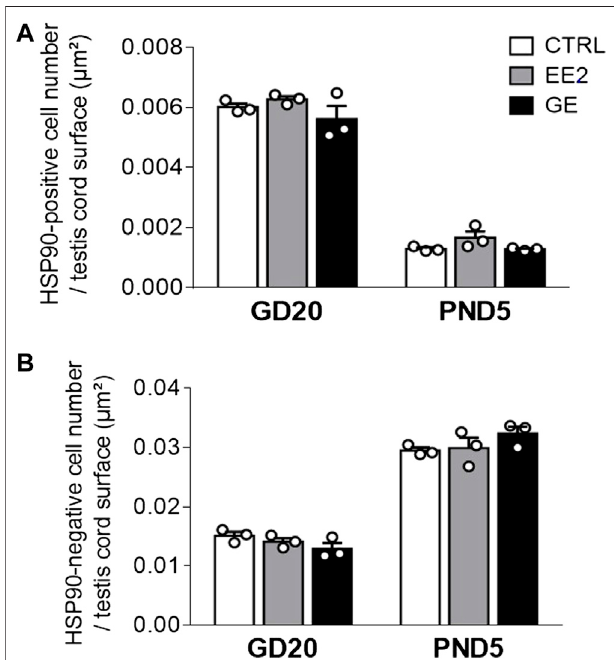
FIGURE 3 | Effects of in utero exposure to EE2 or GE on testis development. Mean density of (A) HSP90-positive cell number and (B) HSP90-negative cell number per testis cord surface within testes sampled on GD20 or PND5 following in utero exposure to either vehicle (CTRL), ethinylestradiol (EE2) or genistein (GE) are represented as mean ± SEM. Individual values are displayed on the graph (n = 3 from different litters/group).